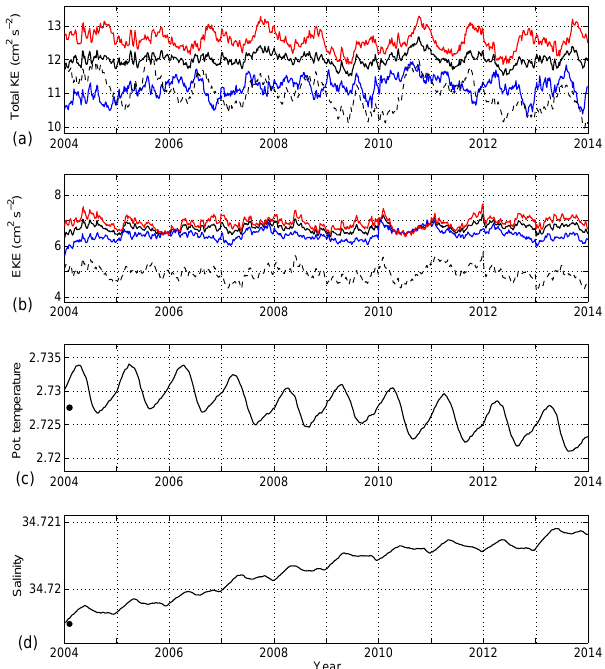
Figure 1. Time variations of volume-averaged (a) total kinetic en- ergy (KE; in cm 2 s − 2 ), where the black line represents the global basin-mean value and the red (blue) the contribution of the Southern (Northern) Hemisphere in GLOB16. Thin-dashed line represents the basin-mean total KE in GLOB4. (b) As panel (a) but for eddy kinetic energy (EKE; in cm 2 s − 2 ). The seasonal cycle of the mean field has been removed. (c) Potential temperature in ◦ C; (d) salinity in psu. Black circles indicate temperature and salinity initial